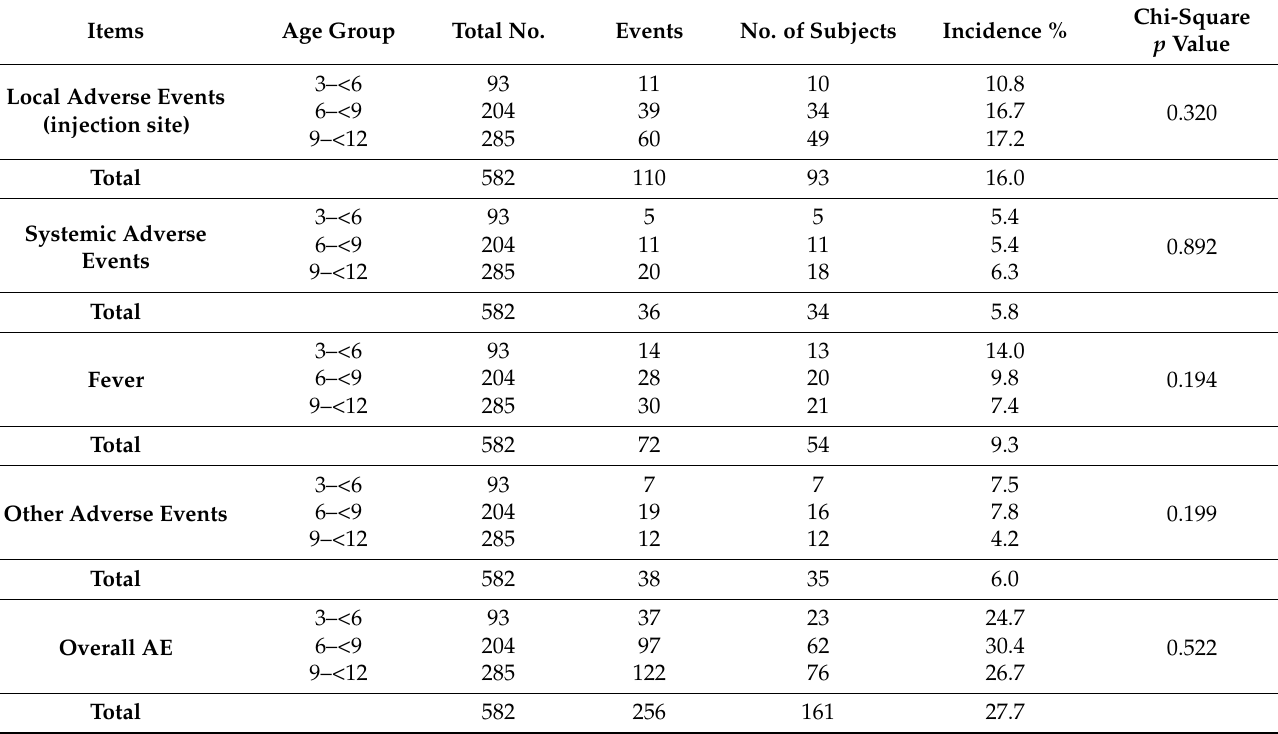
Table 2. Analysis of the incidence of adverse events after the two doses of